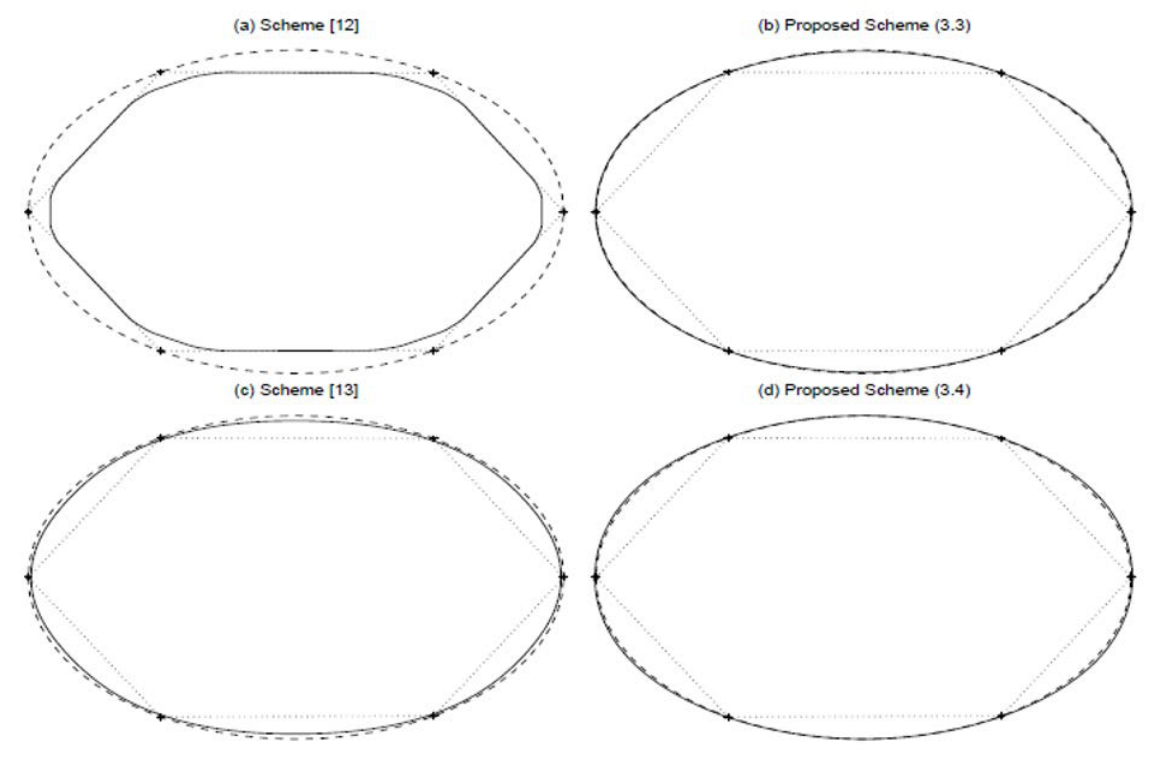
Figure 2. Thereproductionoftheellipseafterthreesubdivisionsteps, thecontinuouslinesrepresentthelimitcurves: scheme[12]in(a), proposed scheme (8) in (b), scheme [13] in (c) and proposed scheme (11) in (d). The broken curves represent the original ellipse and dotted lines represent initial control polygon.